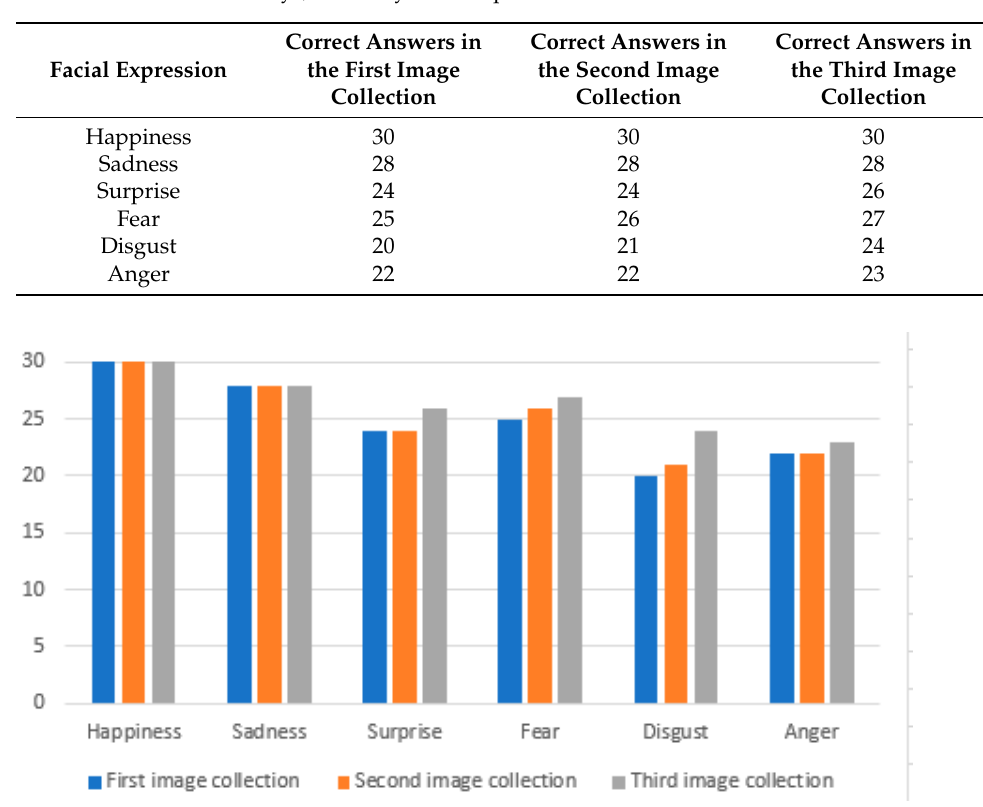
Figure 8. TD children’s interaction with the three face collections.